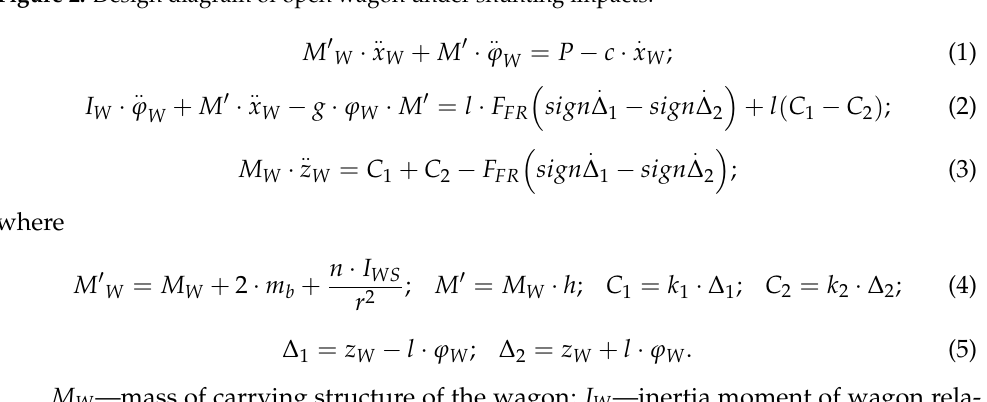
Figure 2. Design diagram of open wagon under shunting impacts.